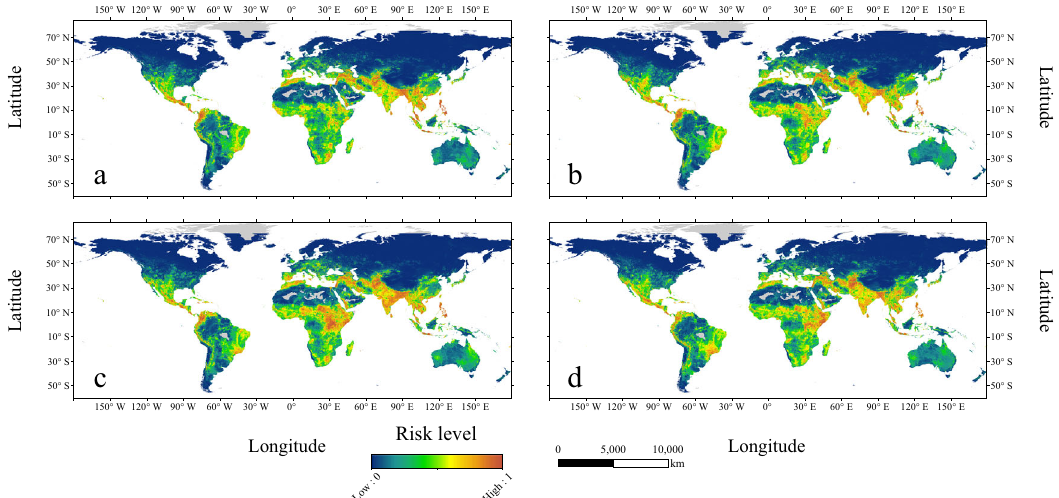
Fig. 3 Maps of the global simulated risk of armed con fl ict incidence at 0.1° × 0.1° spatial resolution. The global risk of armed con fl ict incidence in ( a ) 2000, ( b ) 2005, ( c ) 2010, and ( d ) 2015 were generated by the 20 ensemble boosted regression tree (BRT) models trained on all incidence samples under strategy a + . The simulated risk level ranges from 0 (blue) to 1 (red), and grey denotes the areas with insuf fi cient